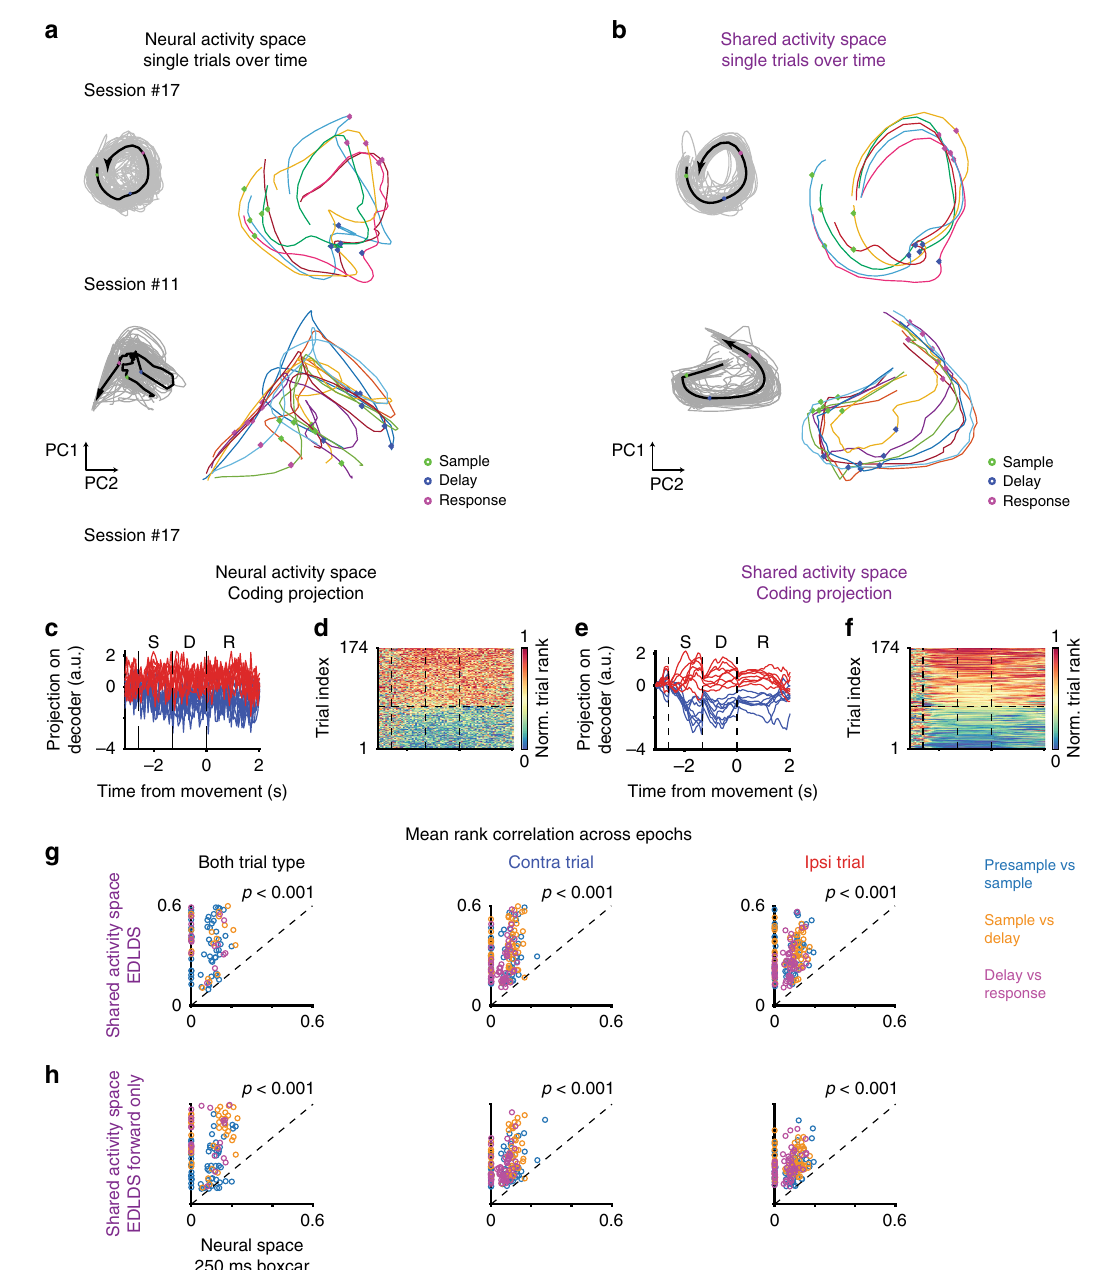
Fig. 4 Maintenance of orderly internal representation of trial identity in the shared-activity space. a – b Neural dynamics spanned by fi rst two principal components (contra trials, Session #17, top; contra trials, Session #11, bottom). Thin lines, single-trial dynamics; black thick lines, averaged dynamics across trials; circles, onsets of behavioral epochs: sample (green); delay (blue); response (red). a full neural space; b shared activity space. Full neural space dynamics shows sharp transitions from one behavioral epoch to the other and random order on single trials. Shared activity space dynamics show smooth transitions in time and strongly ordered dynamics of single trials, where the inner trials (relative to mean) stay inner across time and behavioral epochs. c – f Neural dynamics projected to instantaneous coding directions. c Traces of single trial projections to the trial-types coding direction in full neural space. d Rank of all trials across time. Data sorted according to average rank in sample-delay epochs. e – f The same as c – d except for those in shared activity space. g Scatter of temporal correlations of trial identity across adjacent behavioral epochs in full neural space ( x -axis) and shared activity space ( y -axis). Each dot represents a session, color indicates transition type: between pre-sample and sample epochs (blue); between sample and delay epochs (orange); between delay and response epochs (purple). h the same convention as g except for forward-only pass EDLDS fi t. All p < .001, sign-rank